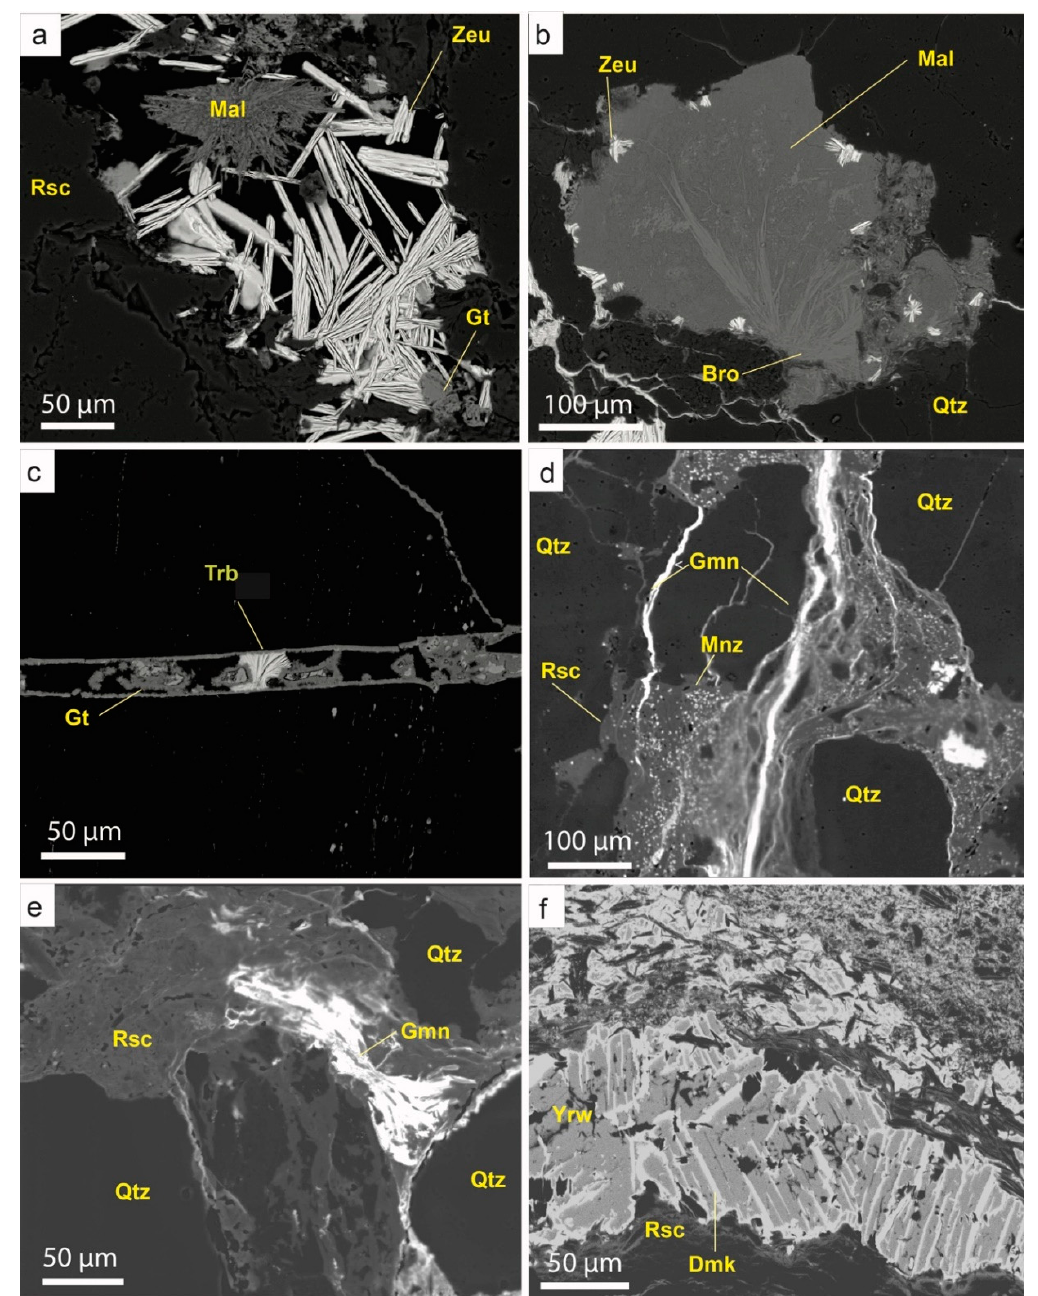
Figure 12. SEM-BSE images of showing the main phosphates and arsenates of the autunite group, as well as some of the uranyl selenites found in the Eureka mine. ( a ) Boxwork filling with goethite (Gt), tabular crystals of zeunerite/metazeunerite (Zeu) and malachite (Mal); ( b ) Full replacement of a copper sulphide by zeunerite/metazeunerite (Zeu), brochantite (Bro) and malachite (Mal) in detrital quartz (Qtz); ( c ) Vein infilling with goethite (Gt) followed by torbernite (Trb); ( d ) Veinlets with guilleminite (Gmn) in roscoelite (Rsc) with monazite disseminations (Mnz); ( e ) Guilleminite (Gmn) replacing roscoelite (Rsc) in detrital quartz (Qtz); ( f ) yarrowite crystals (Yrw) replaced along twinning planes, grain boundaries and cleavage by demesmaekerite (Dmk). Note that roscoelite (Rsc) is arranged along the slaty cleavage.